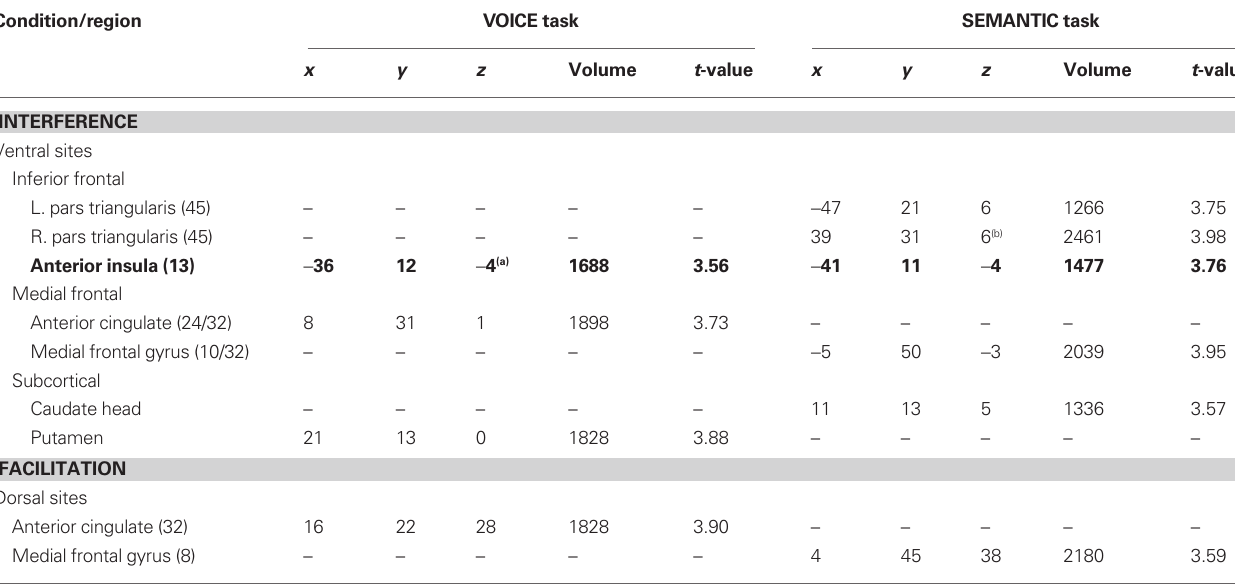
Table 2 | Brain regions, peak coordinates and volumes of activated clusters showing a significant effect of stimulus-level interference (incongruent > neutral words) and facilitation (congruent > neutral words) for the two attentive listening tasks.